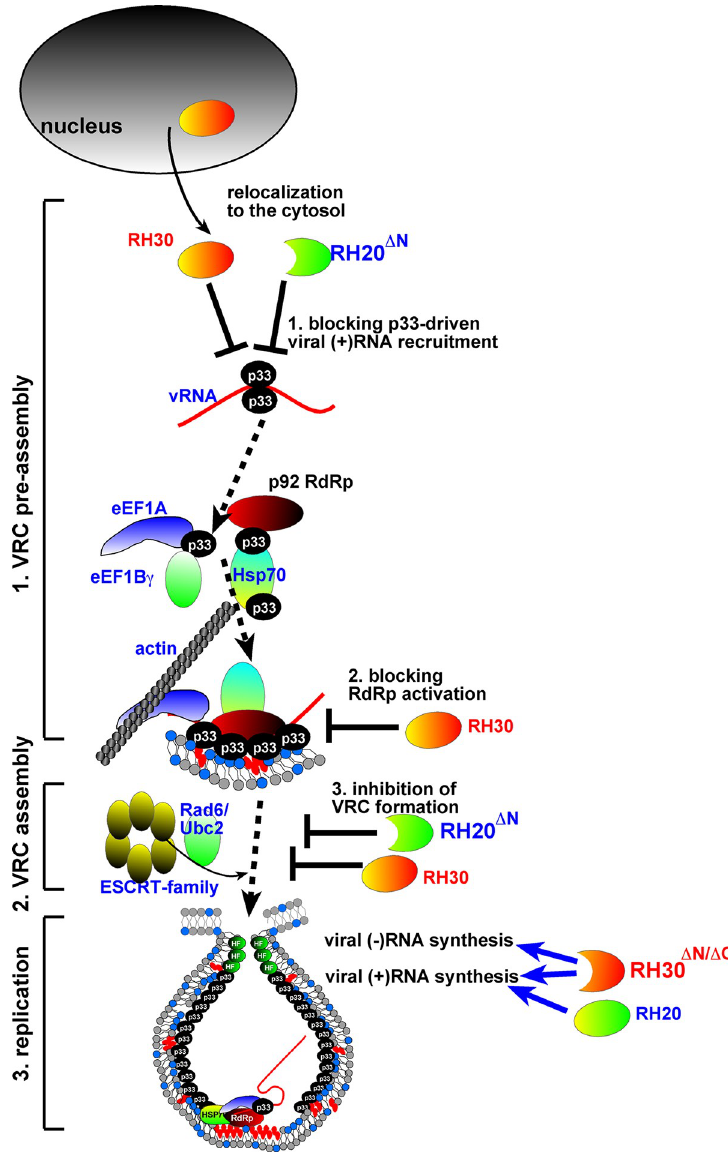
Fig 12. A model showing the acquired functions of the truncated helicases in TBSV replication. Based on our current and previous data, we propose that the RH20 Δ N helicase becomes a novel antiviral restriction factor by inhibiting the recruitment of the viral (+)RNA and, thus, blocking VRC formation. This inhibitory effect of RH20 Δ N helicase is likely through remodeling the structure of the RII(+)-SL cis -acting RNA element, which might block the specific recognition by p33 replication protein, which requires the RII(+)-SL stem-loop structure. RH20 Δ N helicase inhibits VRC assembly as well, because the stem-loop structure in RII(+)-SL is essential part of the VRC assembly platform. In contrast, RH30 Δ N/ Δ C helicase becomes a novel pro-viral factor by opening up the RI-containing dsRNA structure within the dsRNA replication intermediate. This, in turn, RH30 Δ N/ Δ C helicase likely facilitates the initiation of (+)-strand synthesis by the TBSV RdRp. We propose that unlike the full-length RH30, the RH30 Δ N/ Δ C helicase has lost its ability to remodel RII(+)-SL structure, which is required for antiviral activity of RH30.